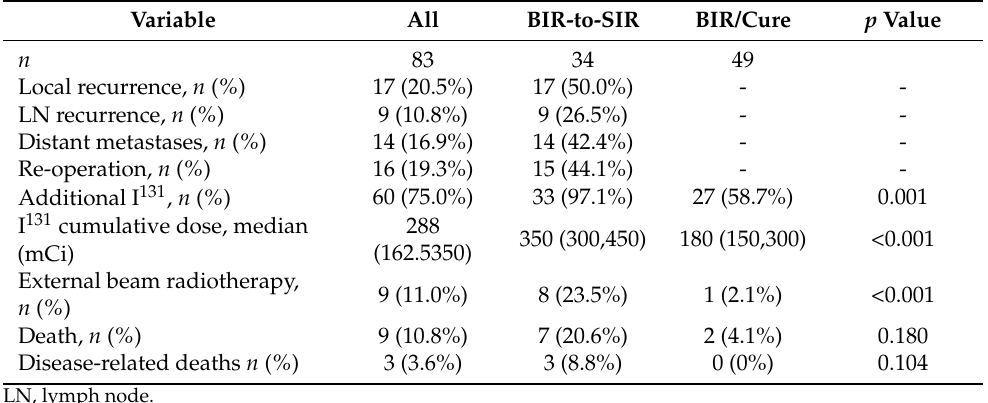
Table 3. Additional treatment and follow-up.